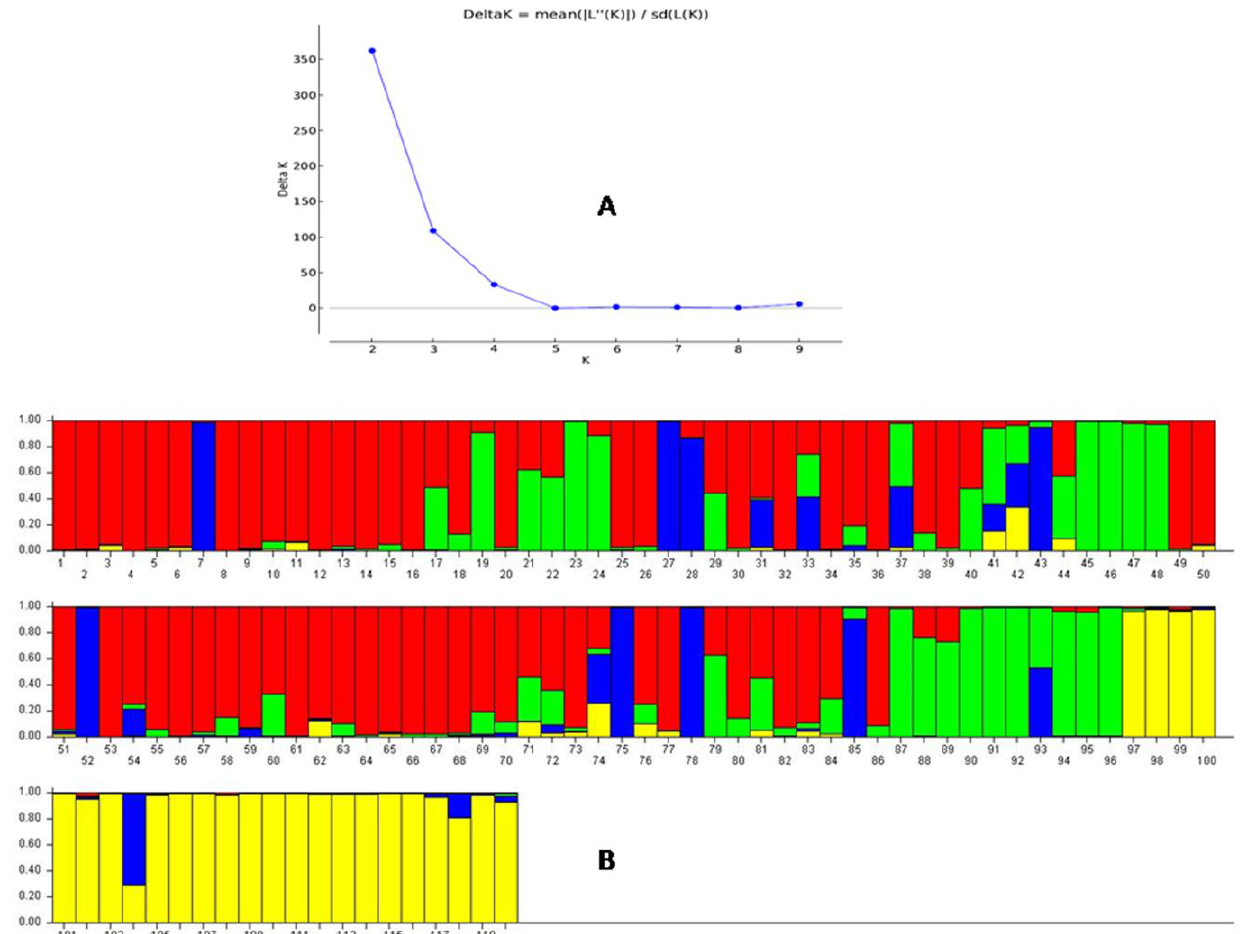
Figure 5. ( A ) Graph of ∆K value, to the rate of change in the log probability of data between successive K values. ( B ) Population structure of the panel population based on membership probability fractions of individual genotypes at K = 4. The genotypes with the probability of ≥ 80% membership proportions were assigned as subgroups, while others were grouped as admixture group. The numbers in the diagram depict the serial number of the germplasm lines listed in the Table 1.